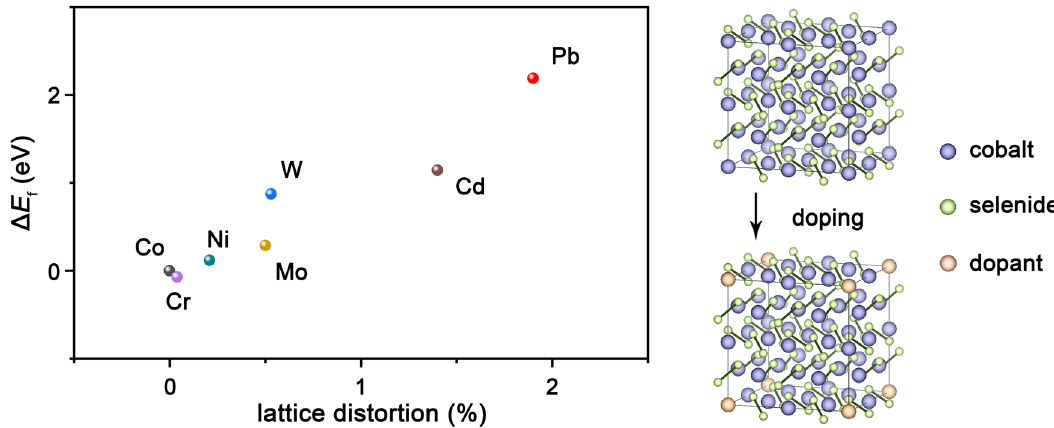
Fig.1|DFTthermodynamicstabilitystudy. CalculatedformationenergiesofvariouscationdopedCoSe 2 asafunctionoflatticedistortion,dopantconcentration:3.125at%. (Right) Structures of pure pyrite CoSe 2 and cation doped CoSe 2 . The balls in purple, green and orange represent Co, Se, and dopants,